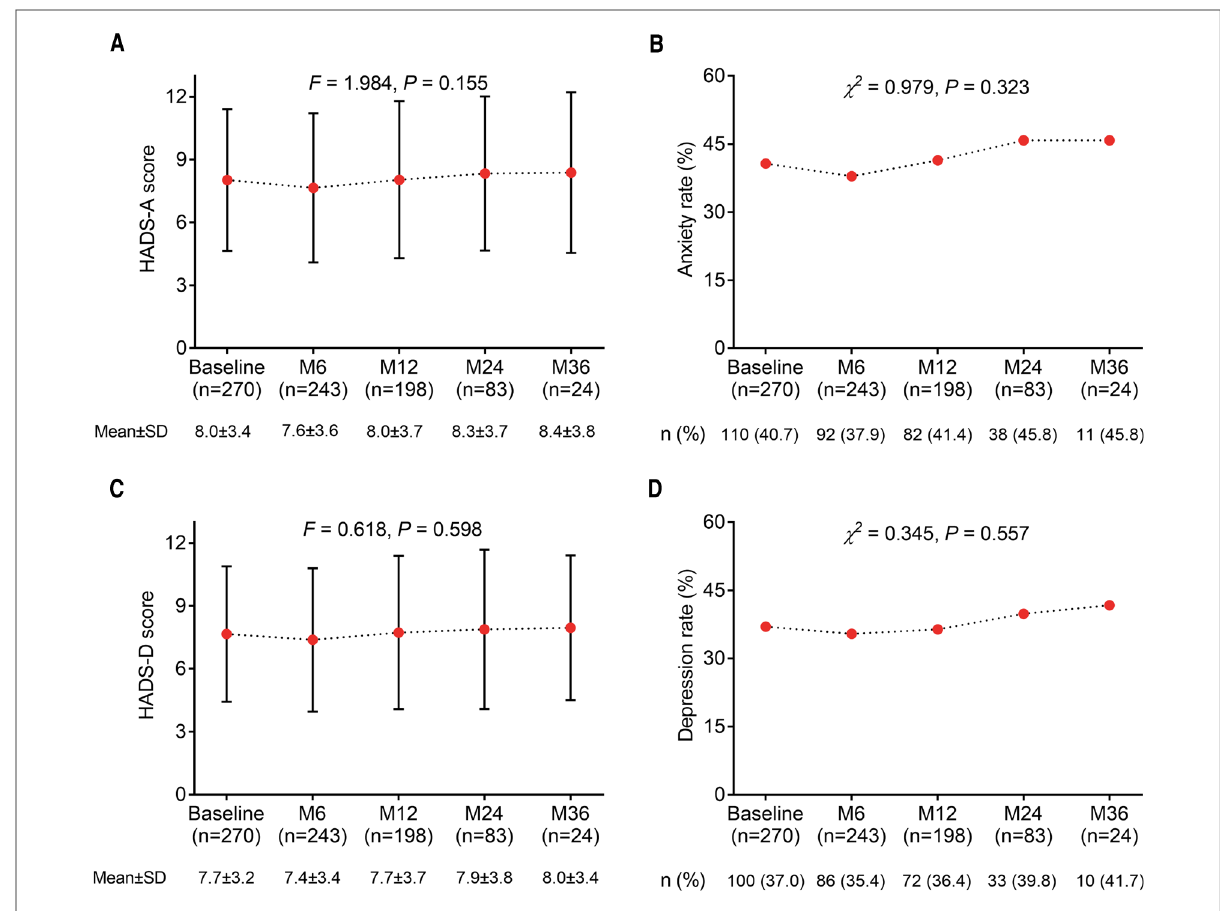
FIGURE 4 Changes in anxiety and depression with different time points in postoperative glioma patients. The HADS-A score ( A ), anxiety rate ( B ), HADS-D score ( C ), and depression rate ( D ) among each time point in glioma